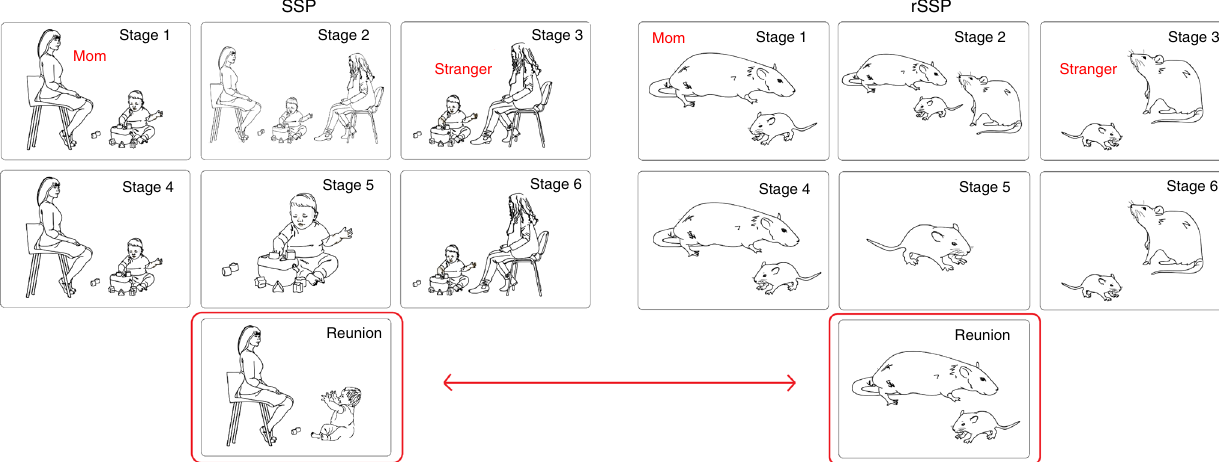
Fig. 2 Translating mother – infant reunion phase of the Strange Situation Procedure across species. The SSP uncovers de fi cits in attachment behavior in children through a series of exposures to a stranger and separation – reunion with the mother, culminating in a fi nal epoch of the child ’ s reunion with the mother 2,10 . Child behaviors during this reunion can signify the quality of attachment to the caregiver. While minor variations in attachment quality suggest individual differences in mother – infant interactions, attachment categories such as disorganized attachment highlight disruptive mother-infant attachment quality and predict later-life pathology 2,68 . Adaptation of the SSP to rodents (rSSP) uses a similar series of epochs with the mother. In rodents, where infants rely on the maternal odor for mother – infant interactions, the mother possessed the natural diet-dependent, learned maternal odor. A “ stranger ” was produced by feeding another lactating dam a different diet (Tekland) that suppressed the natural maternal odor and provided this mother with a novel maternal odor, which was unfamiliar to test pups. Importantly, pups reared with the “ stranger ” mother show strong attachment behaviors to this mother, while our test pups unfamiliar with this “ stranger ’ s ” maternal odor do not. Only the fi nal reunion data from the SSP and rSSP is used to determine attachment quality (outlined in red). The SSP child subjects were 11 – 28 months old, while rat pups were PN13 – 14, an age range across species associated with some mobility and complete dependence on the caregiver for survival 15